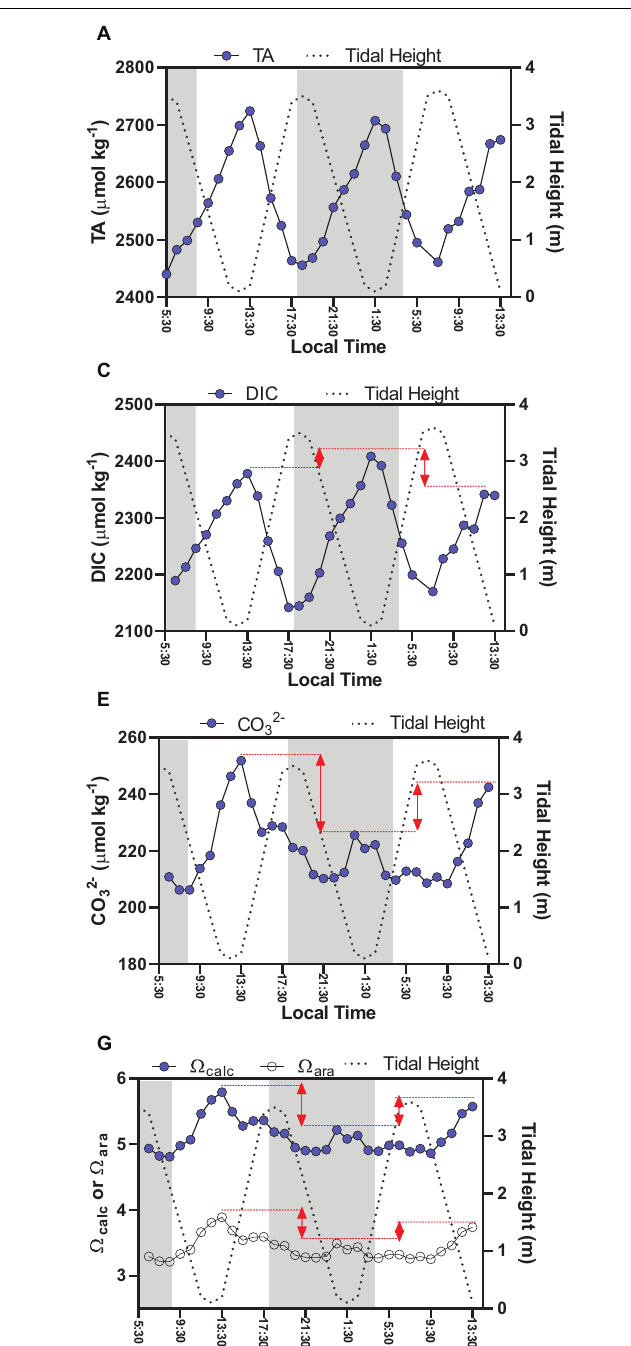
with no statistical difference between these periods. Sep-2018 presented wind velocities averaging 4.73 ± 0.74 m s − 1 for daytime that was higher than the average of 3.47 ± 1.28 m s − 1